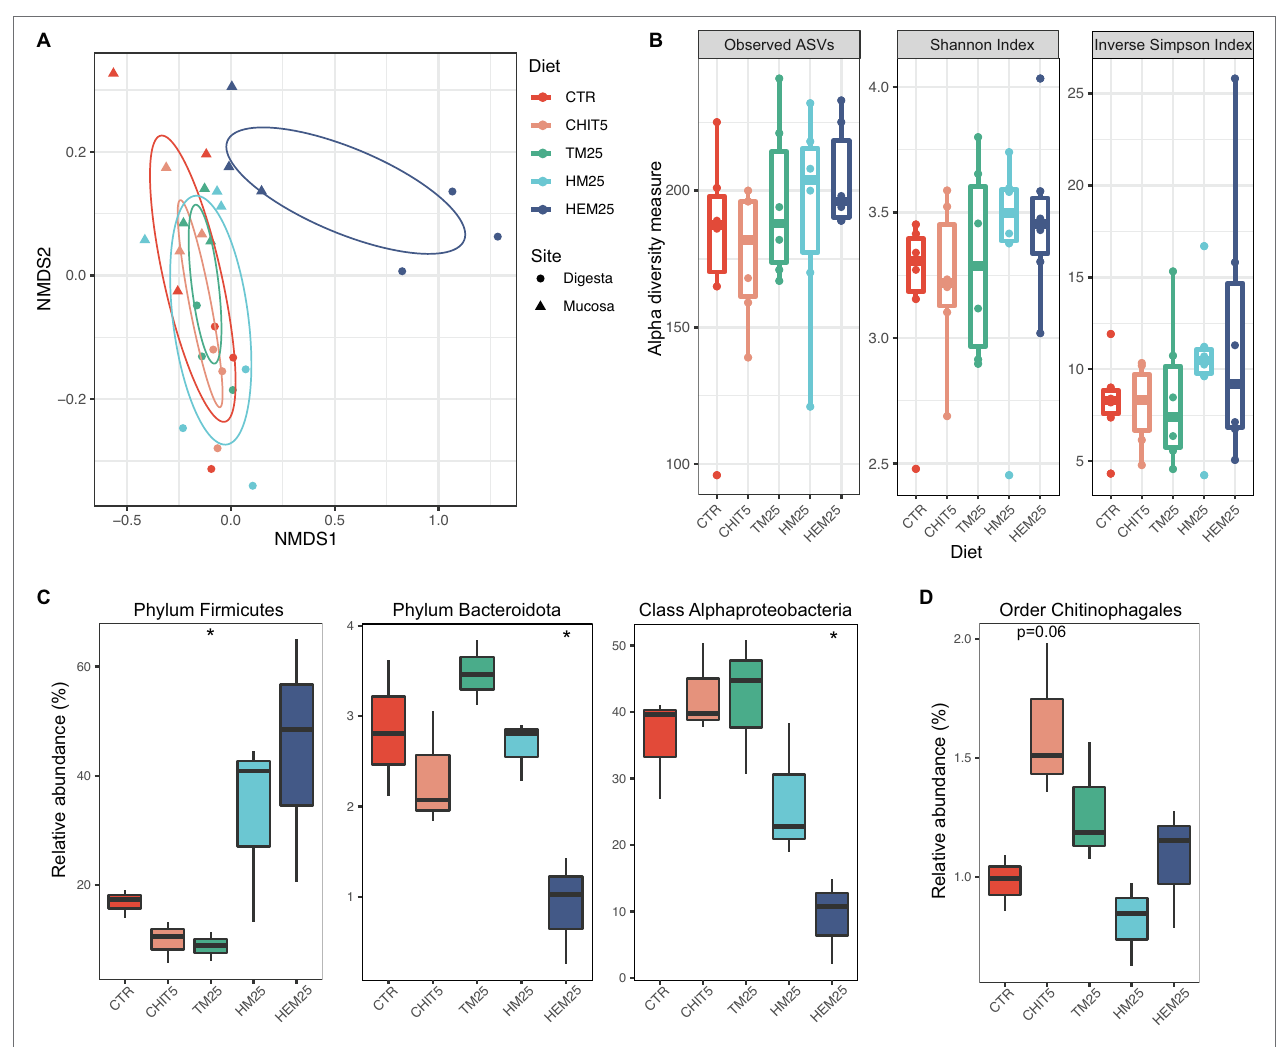
FIGURE 3 | Insect meal-based diets induce major shifts in the European sea bass gut microbiome. (A) Ordination plot based on non-metric multidimensional scaling analysis of Bray–Curtis distances at the ASV level shown in Figure 2B , but now with individual data points colored by diet and shaped by sampling site. SD ellipses (colored by diet) are also depicted. (B) Alpha diversity metrics (number of Observed ASVs, Shannon Index, and Inverse Simpson Index) of samples from different diets. Each point represents one sample ( n = 6 samples per diet). (C,D) Relative abundances of major taxa present in the fish digesta (C) or mucosa (D) which are significantly altered according to diet ( n = 3). Phylum Firmicutes: * p = 0.020; Phylum Bacteroidota: * p = 0.027; Class Alphaproteobacteria: * p = 0.011; Welch two-sample t test. In (B–D) , boxes represent median, first and third quartile. Whiskers extend to the highest and lowest values that are within one and a half times the interquartile